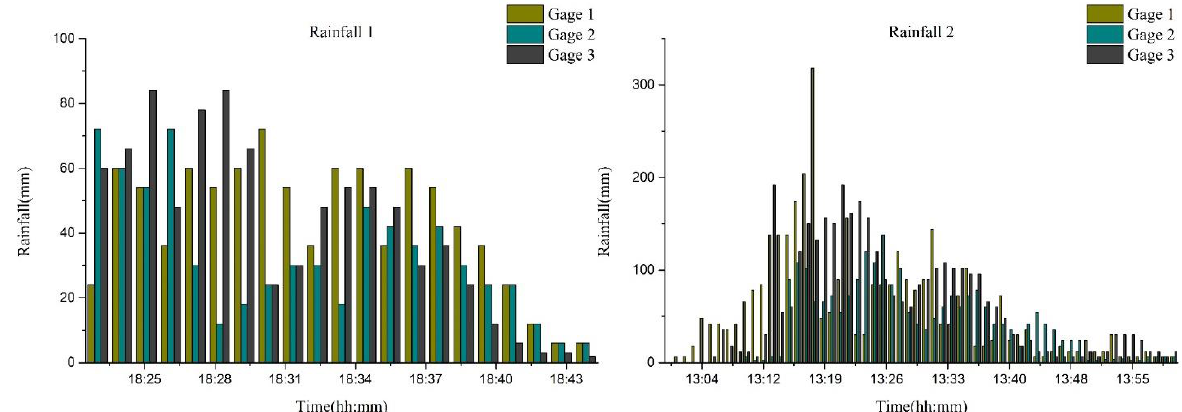
Figure 3. Hydrographs of the two historical rainfall 1 and rainfall 2.